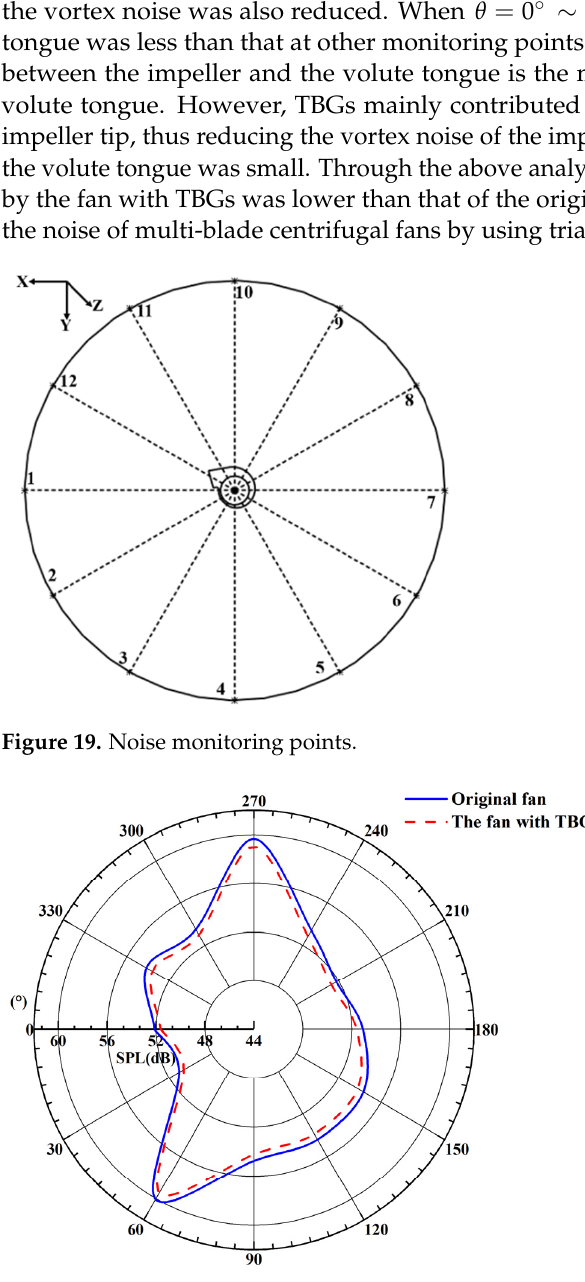
Figure 20. Noise results of original fan and the fan with TBGs.